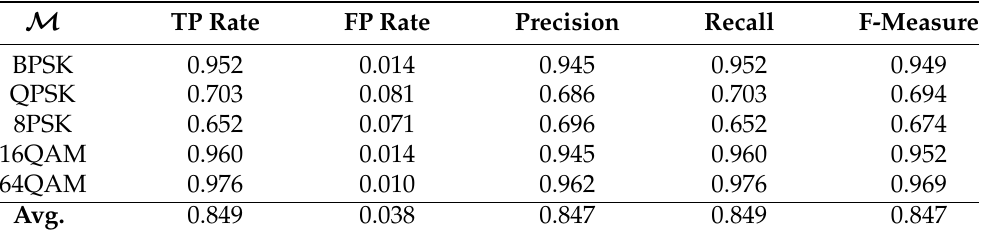
Table 3. Detailed accuracy by modulation type for the random committee using random tree as a